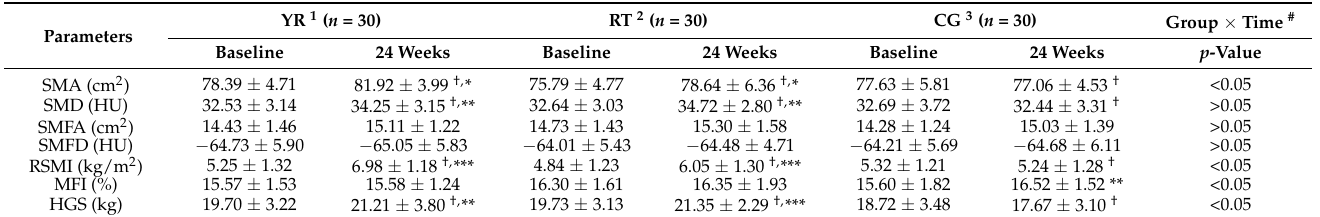
Table 2. Results of a two-way repeated-measures ANOVA at baseline and 24 weeks for each group.